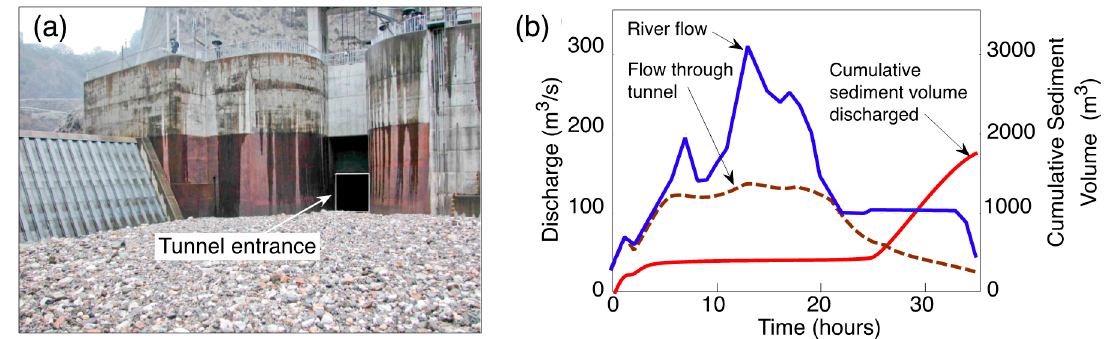
Figure 5. ( a ) Photo of the entrance to the bypass tunnel at Asahi pumped storage reservoir, Japan,